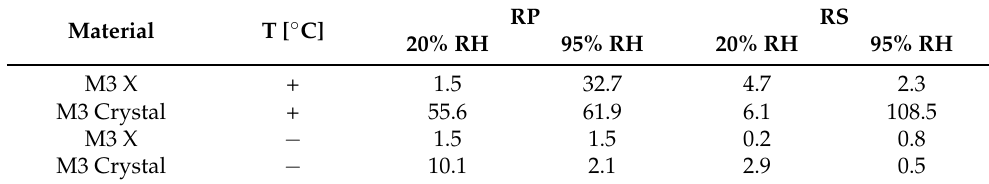
Table 9. Strain differences (%) between sample RW and the other samples for attached ( z ) sensors.